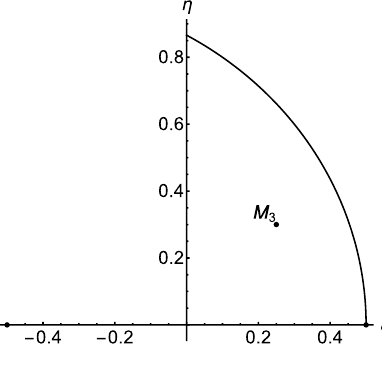
Fig. 1. Agekian-Anosova region